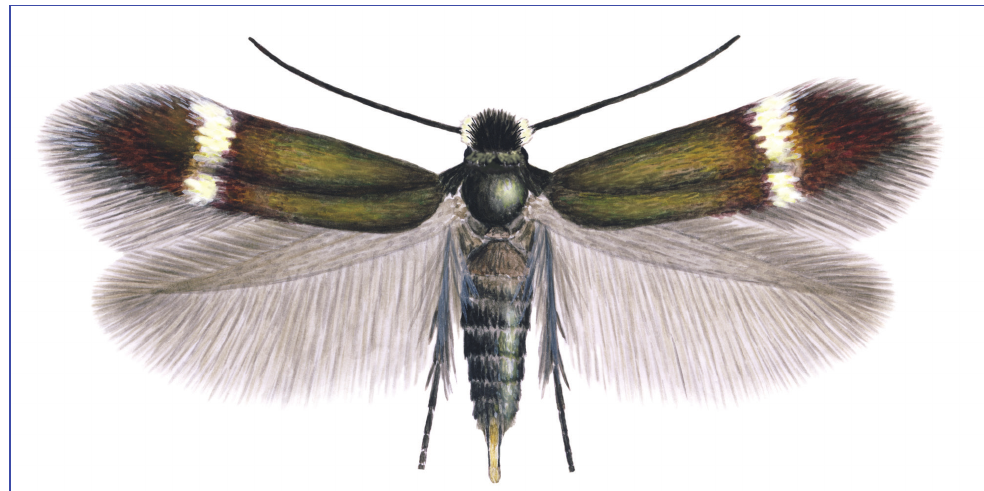
Figure 2. Stigmella tatrica sp. n., female, paratype, Belianske Tatra Mts, Zadné Jatky Mt., 30.vii.2016, wing - span 4.5 mm.